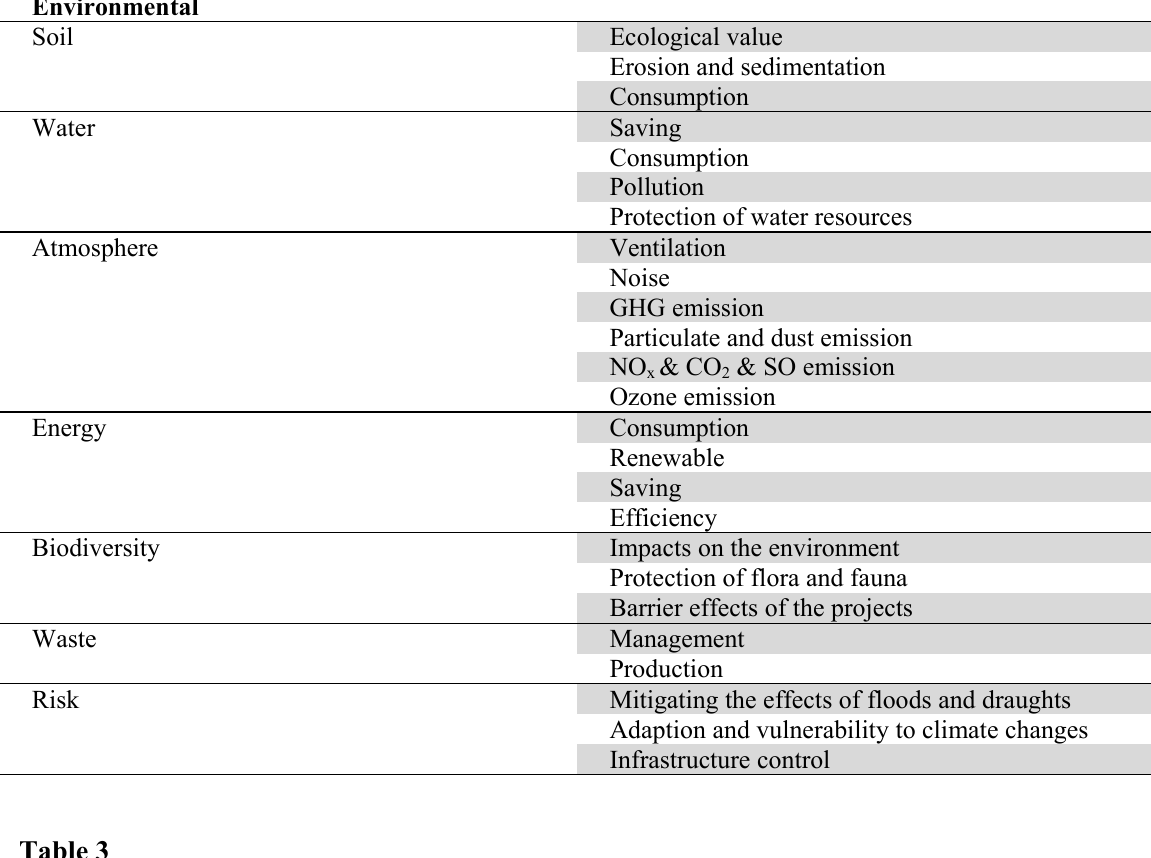
Social criteria